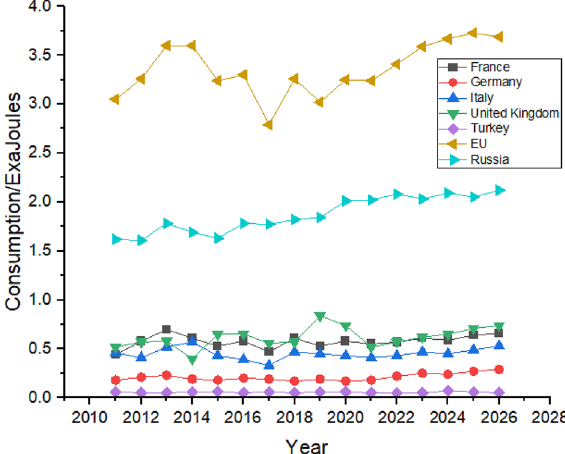
Figure 15. Hydroelectricity consumption in European Region.